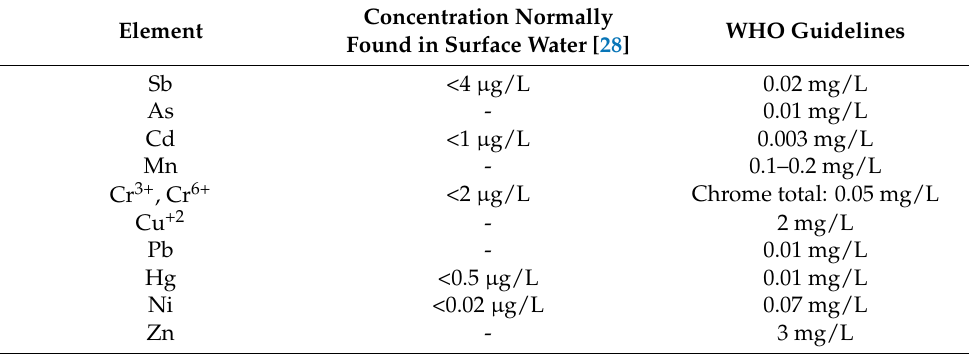
Table 1. World Health Organization’s quality guidelines for drinking water [29]. Element